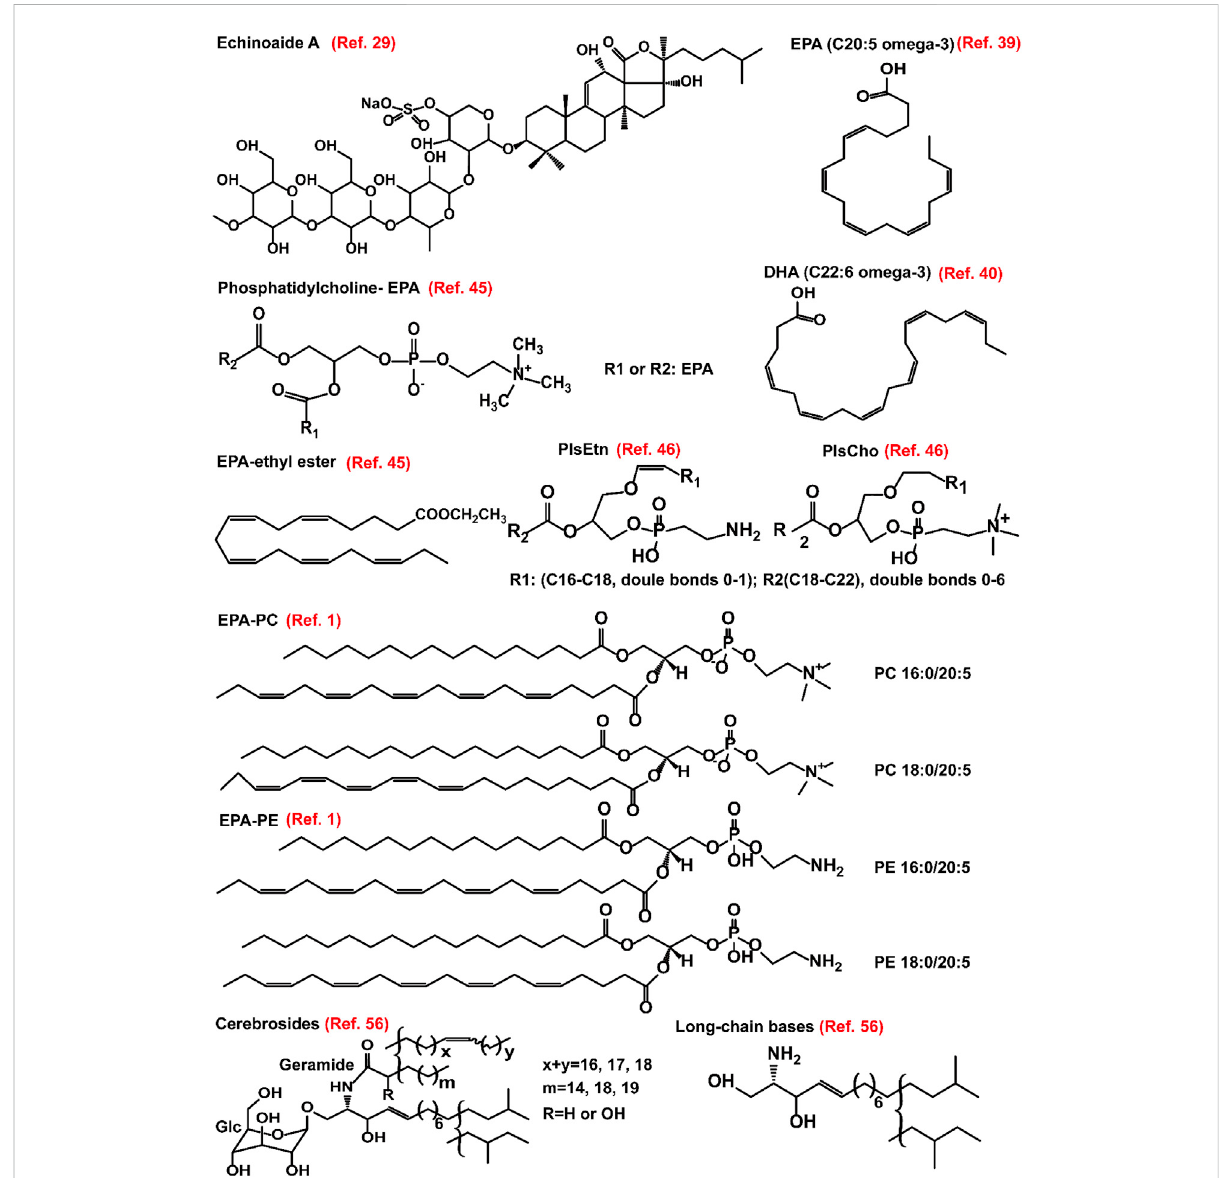
FIGURE 1 Structureofrepresentativesmallmoleculesthatarederivedfromseacucumbers.Thesesmallmoleculesarefoundtomodulatehyperlipidemia in different models including non-alcoholic fatty acid disease and atherosclerosis. EPA, eicosapentaenoic acid; DHA, docosahexaenoic acid; PC, phosphatidylcholine; PE, phosphatidylethanoamine; PlsCho, plasmanyl phosphatidylcholine; PlsEtn, plasmenyl